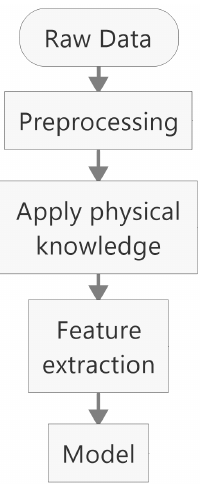
Figure 8. Flowchart of hybrid machine